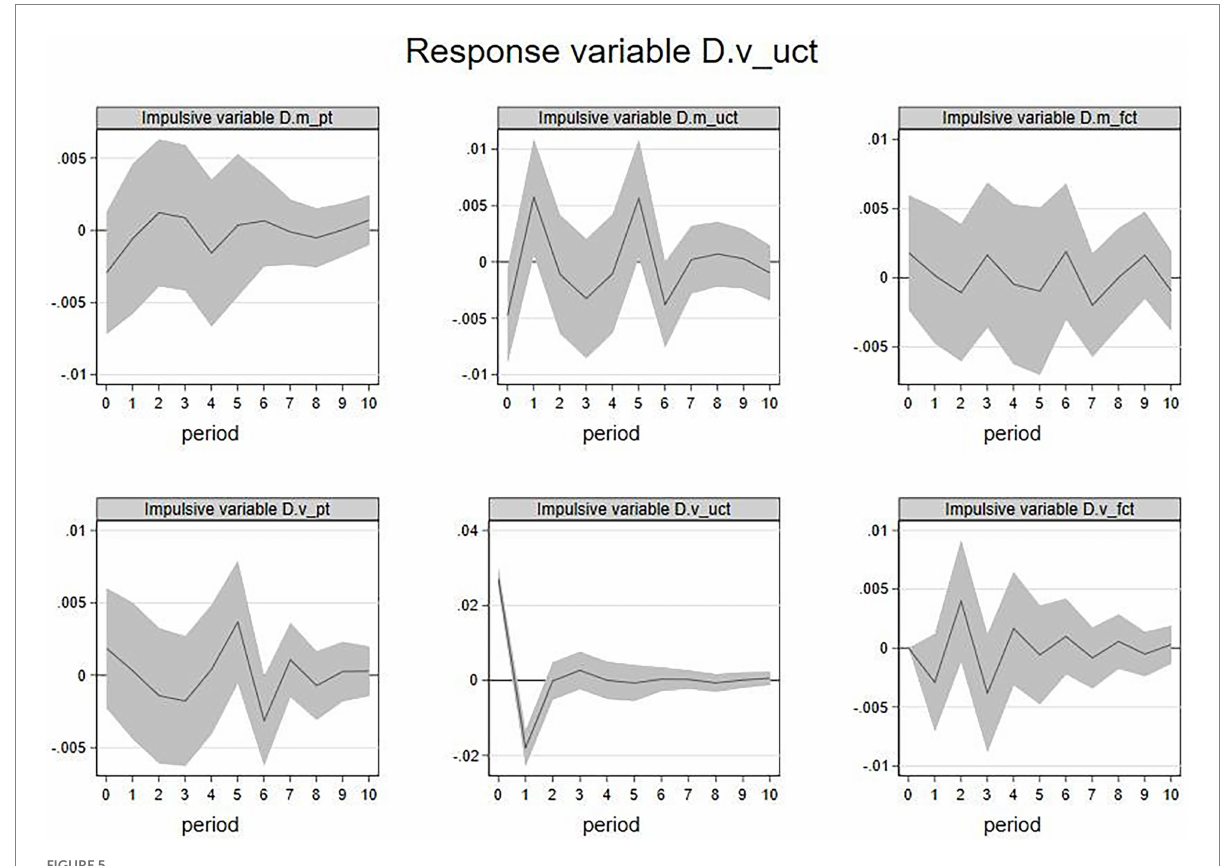
FIGURE 5 IRF: _ D.v uct (response